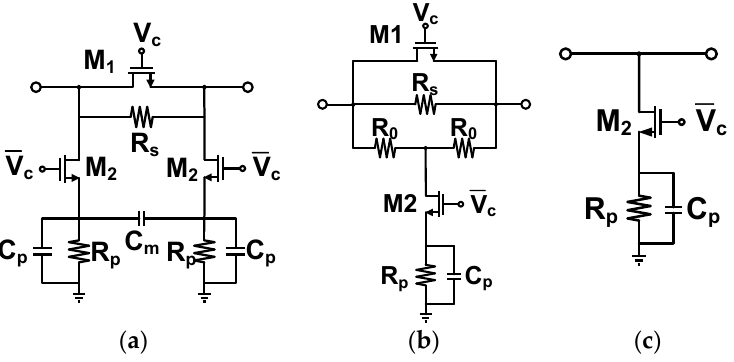
Figure 2. ( a ) The modified π -type for the large value attenuator. ( b ) The modified bridged T-type for the middle value attenuator. ( c ) The modified reduced T-type attenuator for the small value